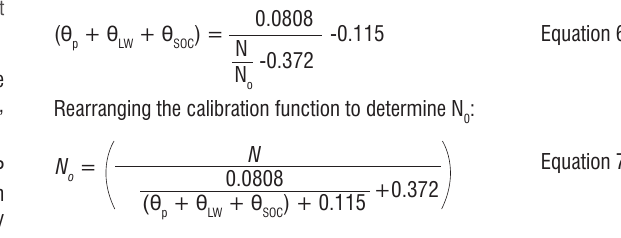
The gravimetric method was used to obtain soil samples within the CRP footprint, to determine the area-average soil moisture for the calibration of the CRP. The gravimetric soil moisture content is expressed,